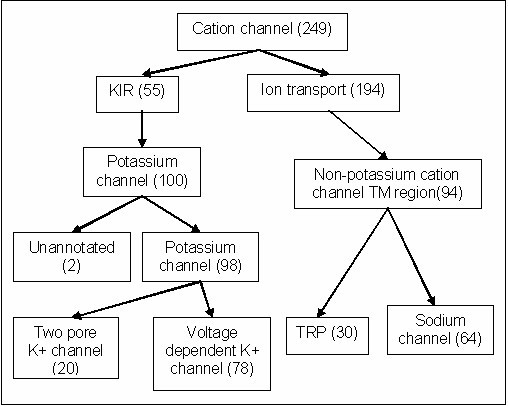
Graph of the ProtoNet tree of cation channels. Squares represent clusters, arrows represent tree hierarchy between clusters. Names are the annotations that were assigned to the clusters as described in text. Parantheses show the number of proteins in the cluster. Note one cluster containing two proteins that was not assigned an annotation.